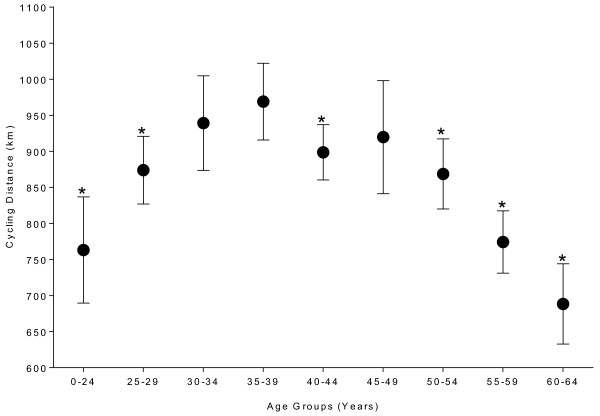
Age-related changes in male cycling performances in the ’24 Stunden Schötz’ from 2000 to 2011, * = significantly different from the fastest age group (i.e. 35–39 years). For women, not enough data were available for statistical analyses.